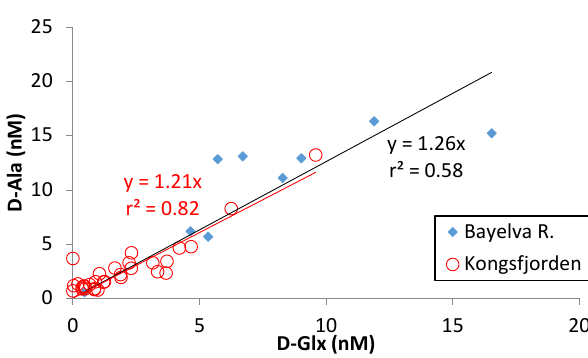
Figure 3. D-Ala plotted against D-Glx for both river ( S = 0) and fjord ( S> 0) suspended particulate